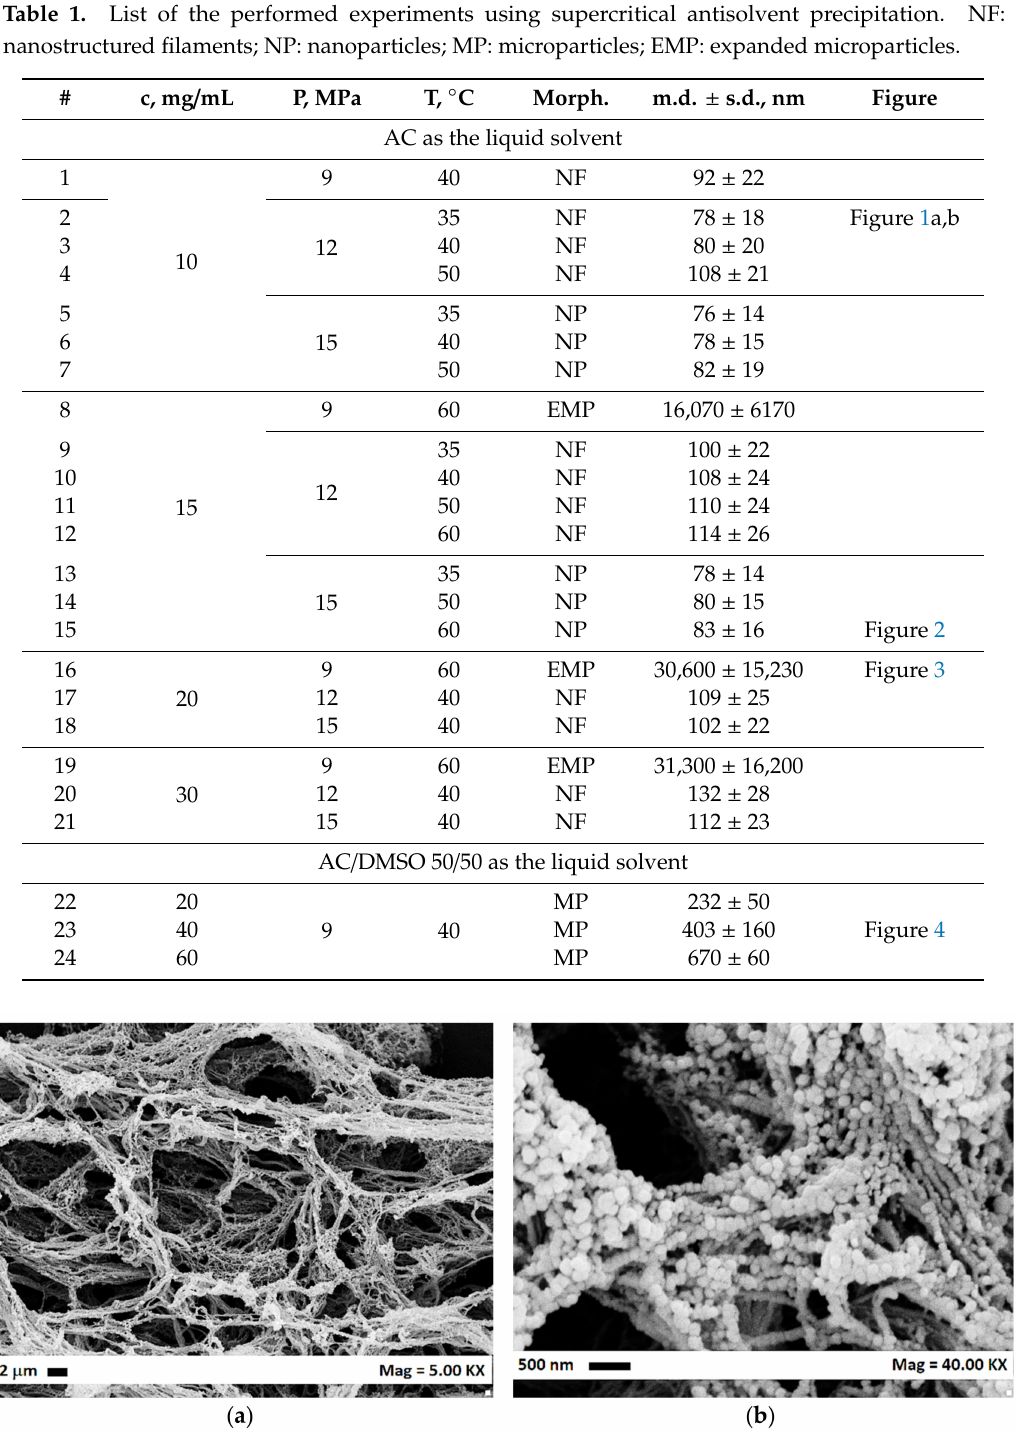
Figure 1. CA filaments obtained at 12 MPa, 35 ◦ C and 10 mg / mL; ( a ) FESEM image at 5 KX; ( b ) FESEM image at 40